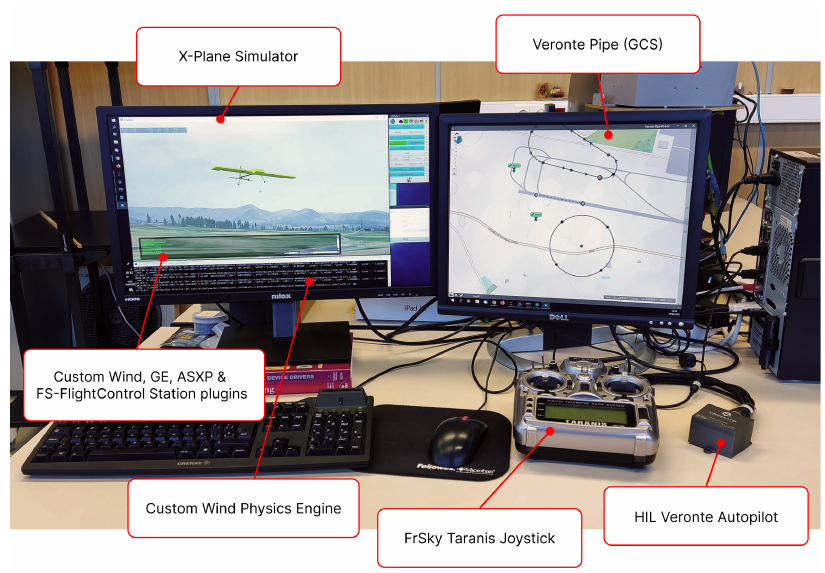
Figure 7. Annotated photograph of the full working setup as seen by a pilot during training.